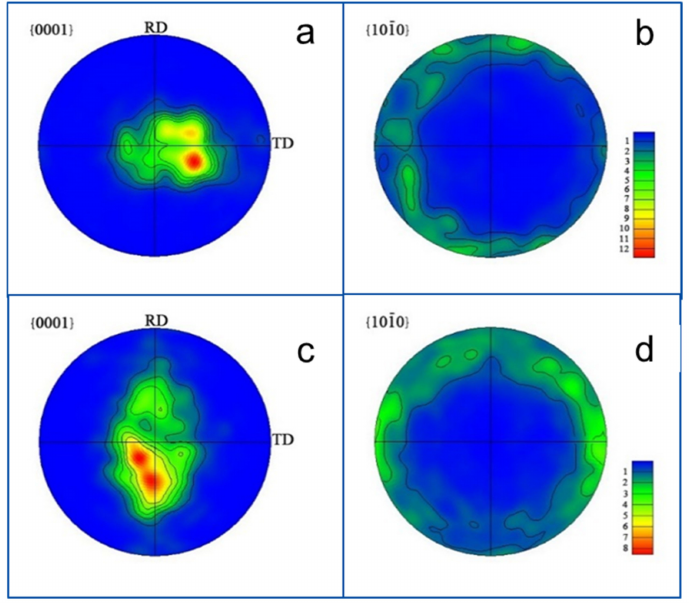
Figure 7. EBSD pole figures of cold-rolled deformed TA2 alloy after nitriding. ( a , b ) 40% deformed and ( c , d ) 80%